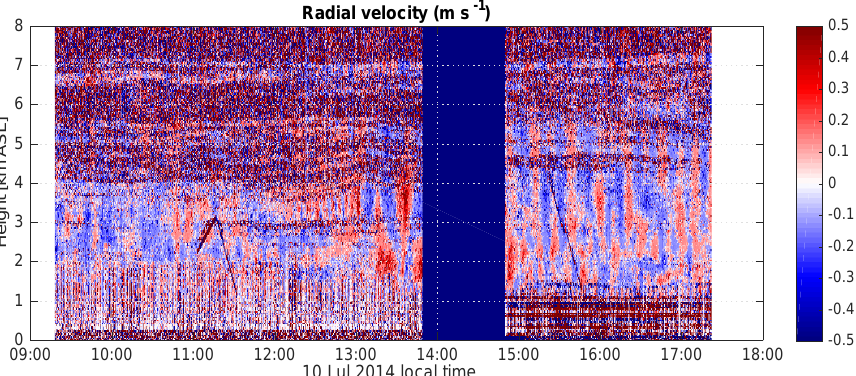
Figure 4. Daytime vertical velocity for 10 July 2014 shows stratified layers in the morning evolving into updrafts and downdrafts in the afternoon with a periodicity of approximately 10min. The propagation of the updrafts reached altitudes close to 7km.